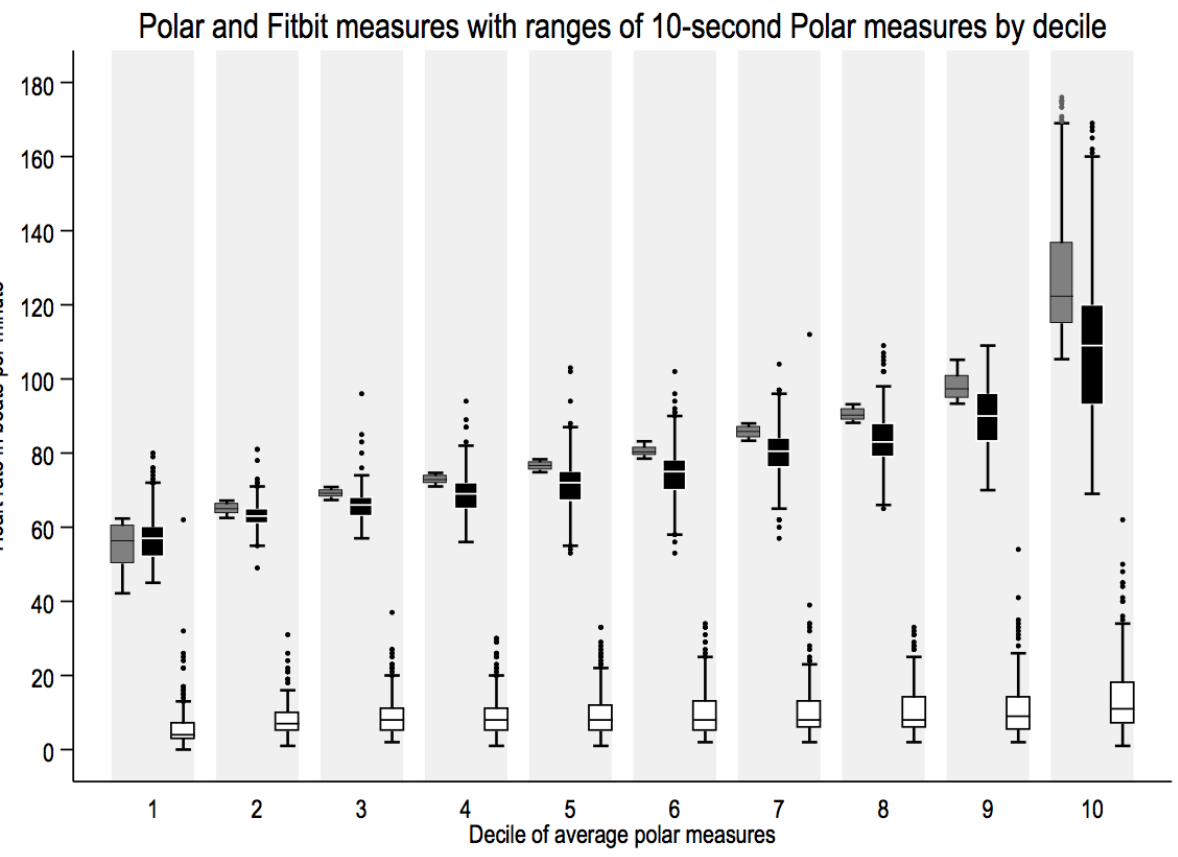
Figure 2. Box-plots providing by-decile comparisons of average Polar (dark gray) and Fitbit (black) measures, width of within-epoch ranges of 10-second Polar measures (white) included